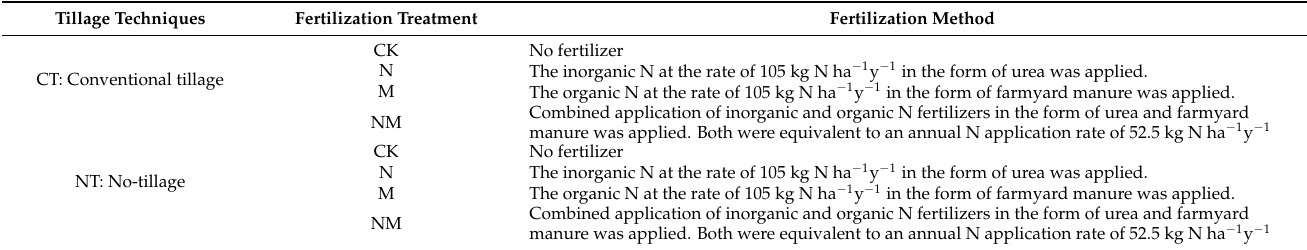
Table 2. Tillage practices and fertilization methods during the